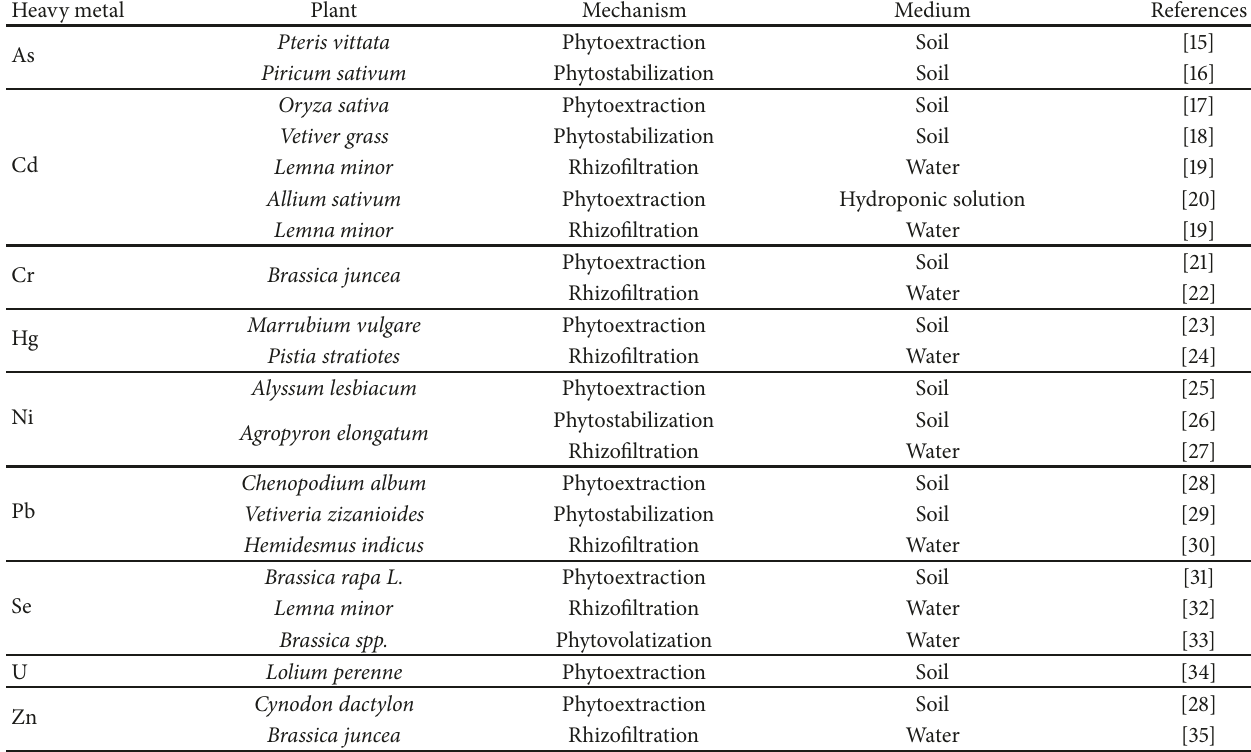
Table 1: Hyperaccumulators reported for phytoremediation of heavy